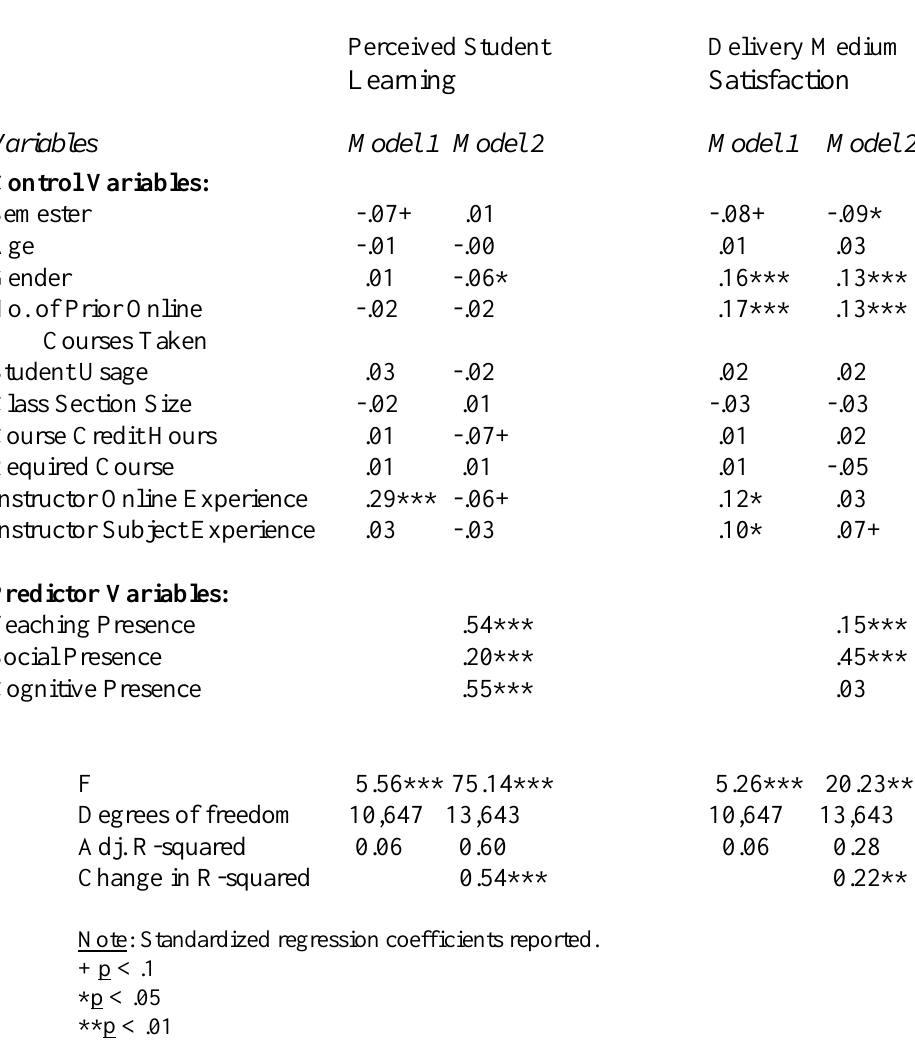
Table 3 . Results of regression analyses on dependent variables ( N =